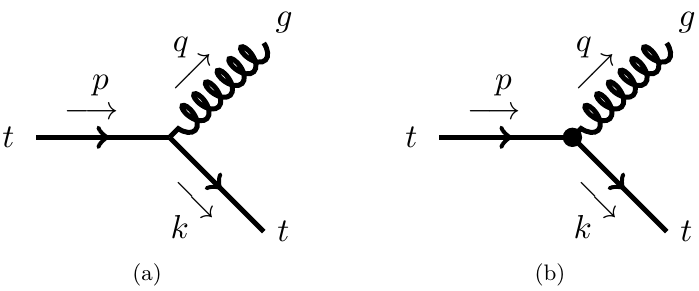
Figure 1 . The splitting of gluon from the (a) SM t - t - g vertex, and (b) anomalous t - t - g vertex generated by the O tG